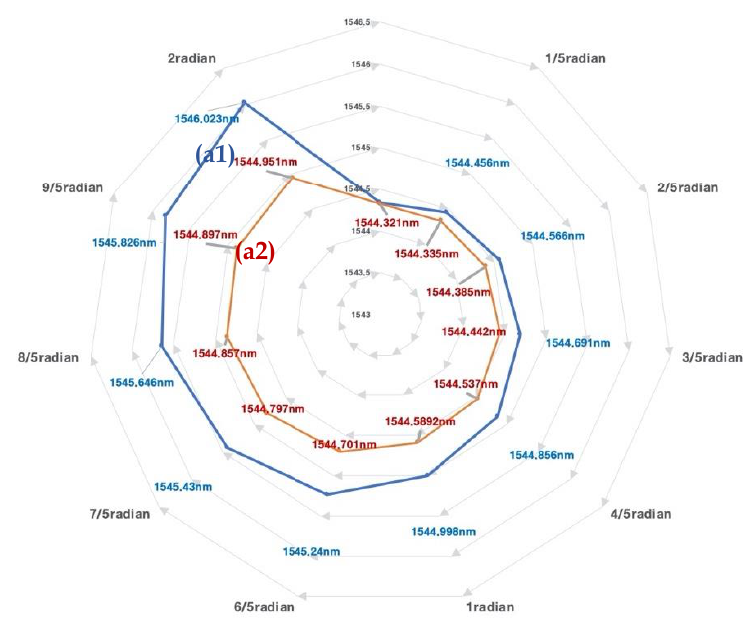
Figure 10. ( a1 ) The sensor stress–strain wavelength shift before braiding. ( a2 ) The wavelength variation after braiding. The wavelength shifts according to 1 radian.